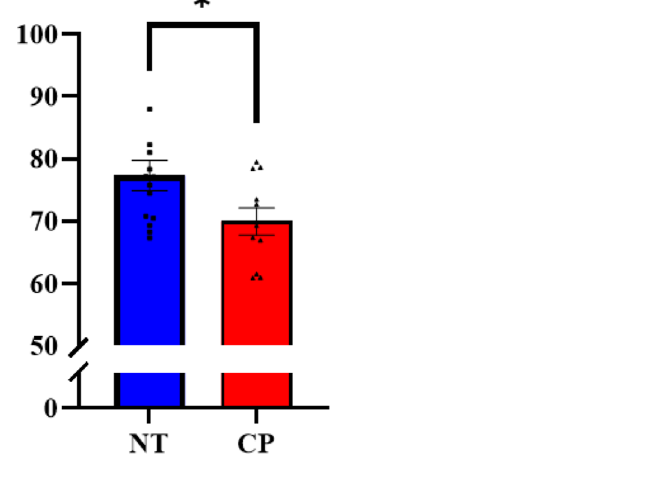
Figure 6. Total cross-sectional area (CSA) of the spinal cord. Individuals with cerebral palsy (CP) had a smaller total CSA than the neurotypical controls (NT). *P <